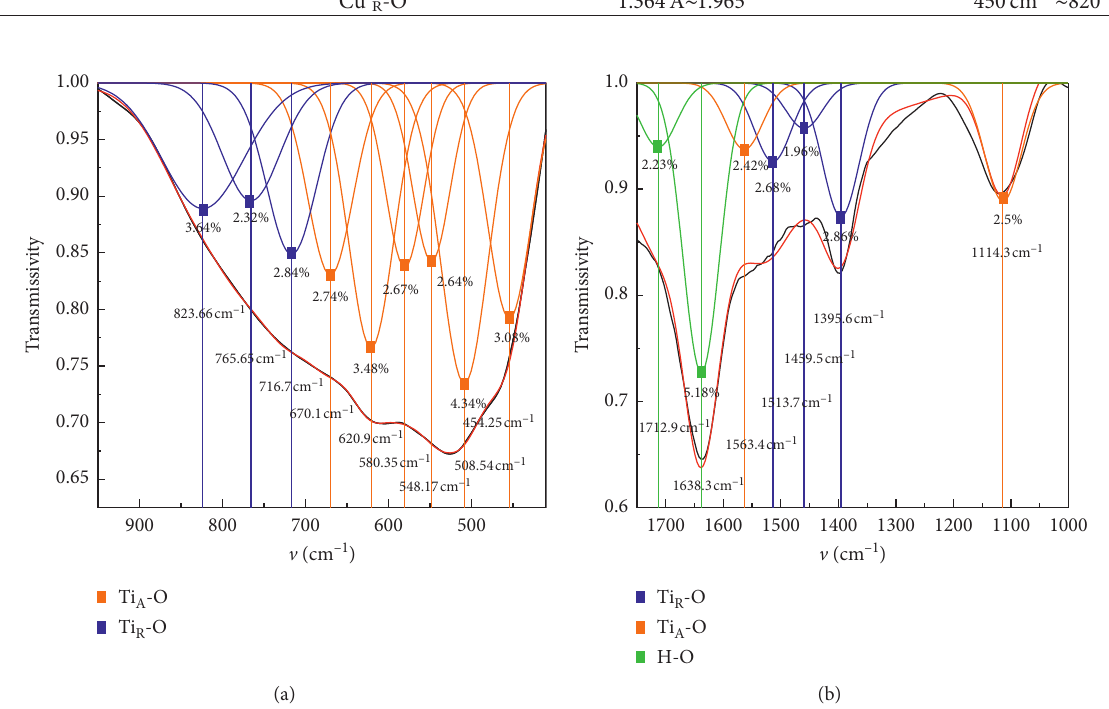
° C). (a) 400cm − 1 ∼ 1000 cm − 1 ; (b)